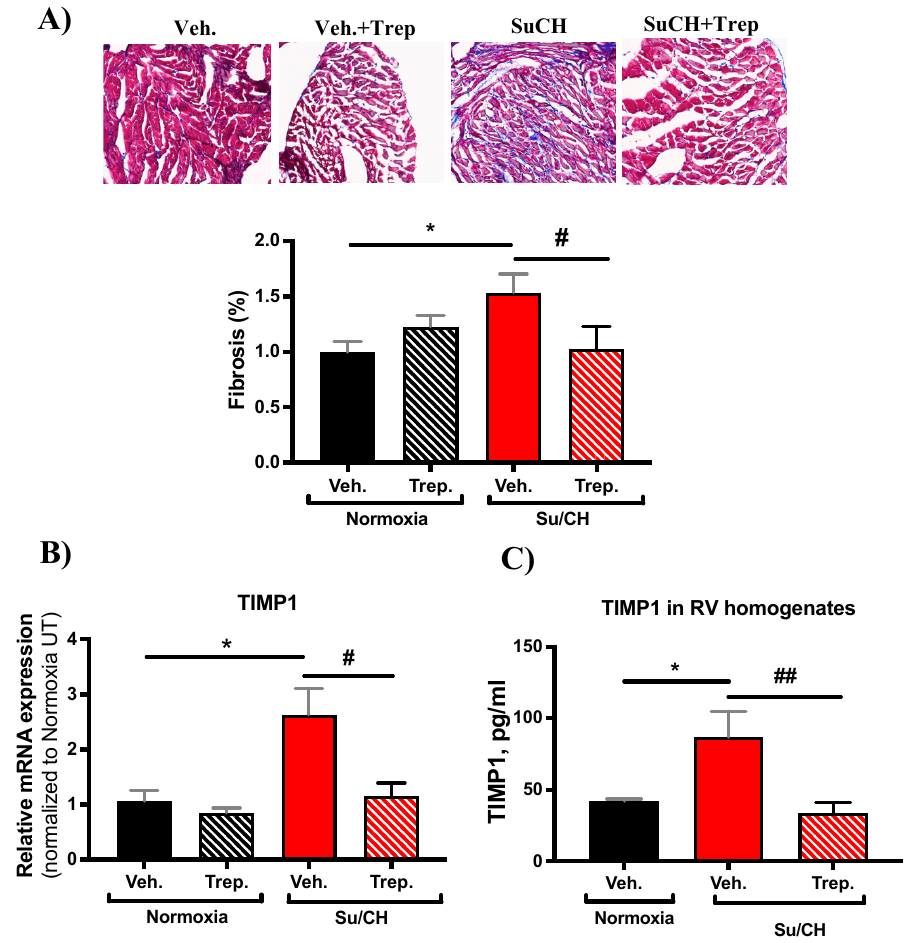
Figure 7. Outcome of treprostinil treatment on RV fibrosis. ( A ) Representative Masson’s Trichrome-stained RV tissue images and bar graph quantification of fibrosis (% fibrotic area/ total area normalized to normoxia+Veh.); ( B ) bar graph presenting transcript level of TIMP1 normalized to normoxia+Veh.; and ( C ) bar graph presenting TIMP1 protein-level quantification in RV tissue homogenates by ELISA; n = 4–5 animals/experimental group; * and # present significance vs. normoxia+Veh. and SuCH+Veh., respectively; * and # p ≤ 0.05; ## p ≤ 0.01.